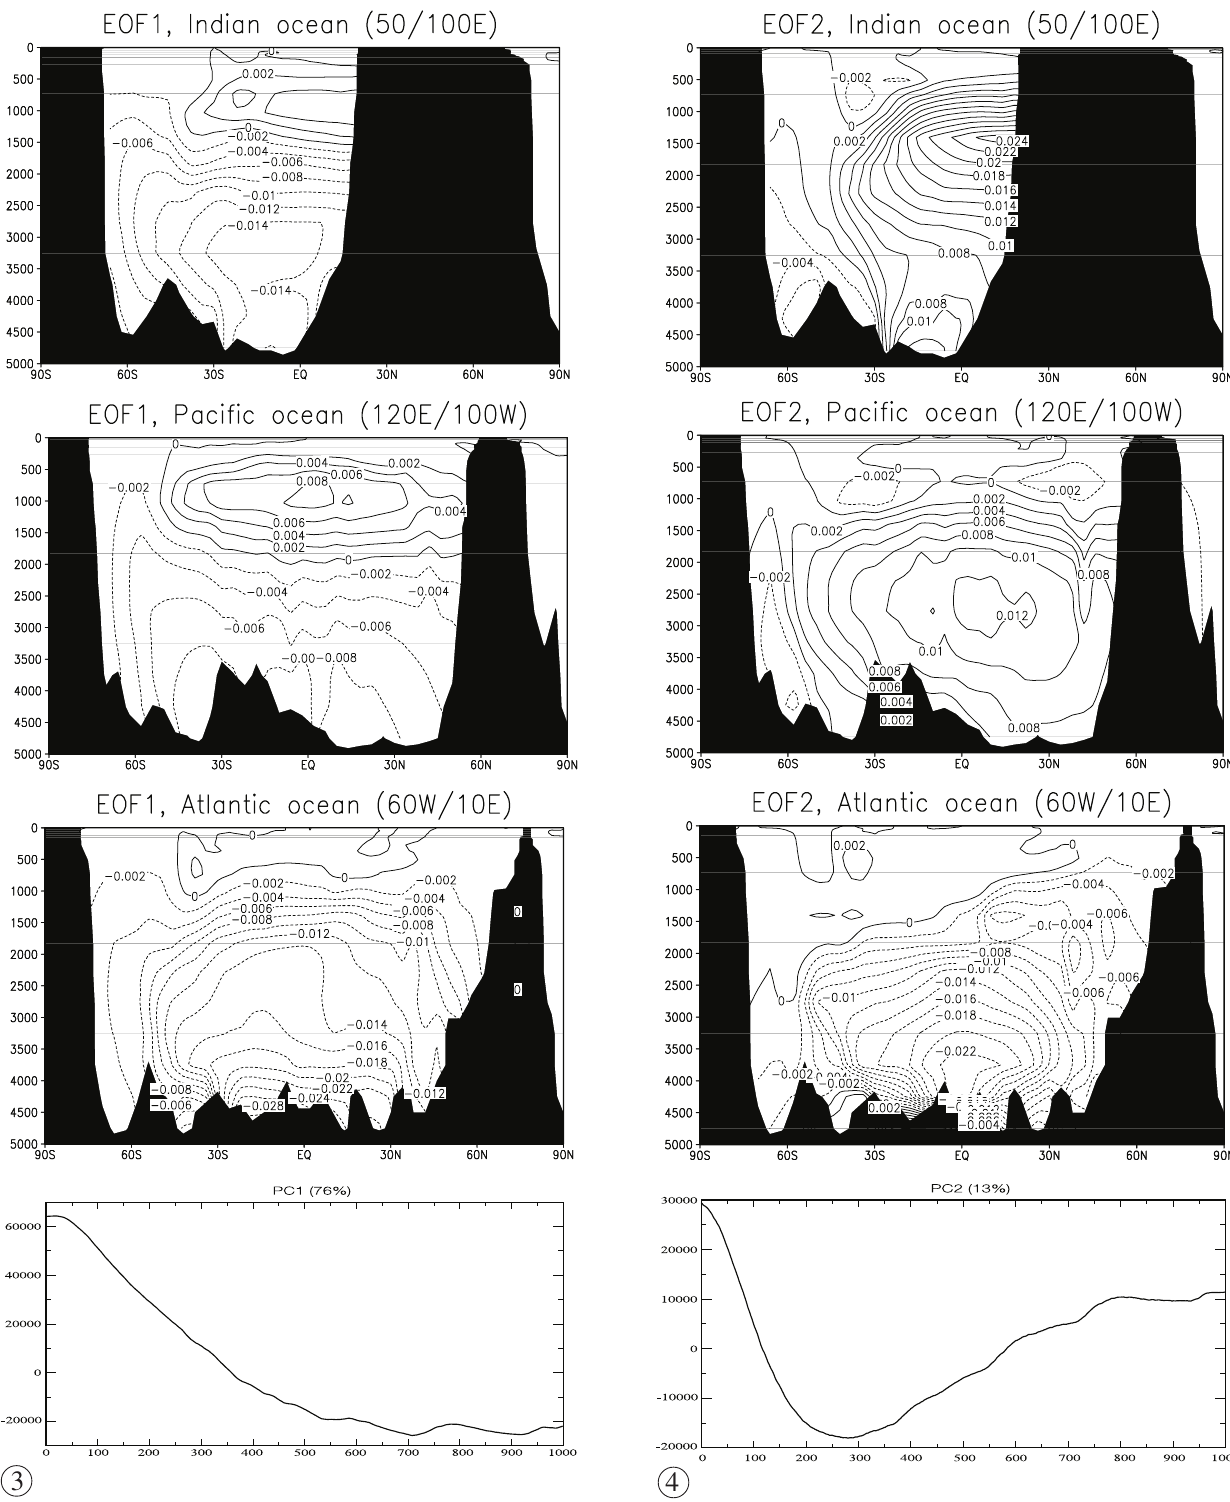
Fig. 3. Spatial structure and time series (arbitrary units) of the leading Empirical Orthogonal Function (EOF) for the 3-dimensional oceanic temperature. The spatial structure is plotted separately for the three basins in the form of zonal average. Fig. 4. Same as in fig. 3, but for the second